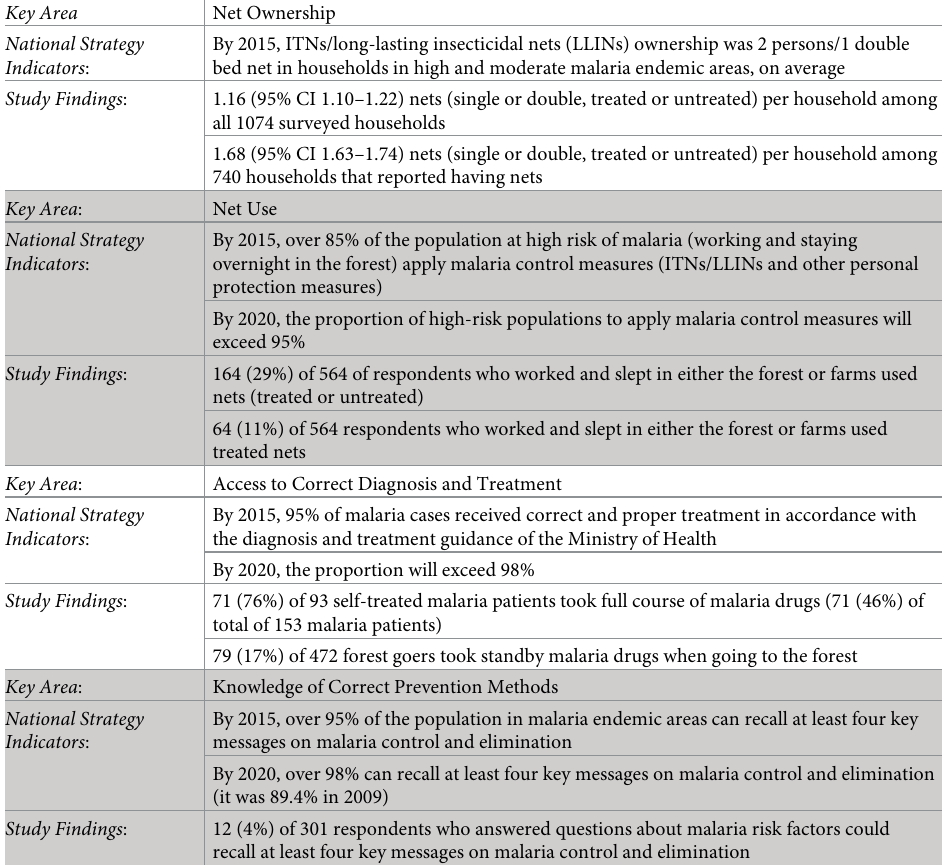
Table 6. Comparison of key survey results to national strategy malaria